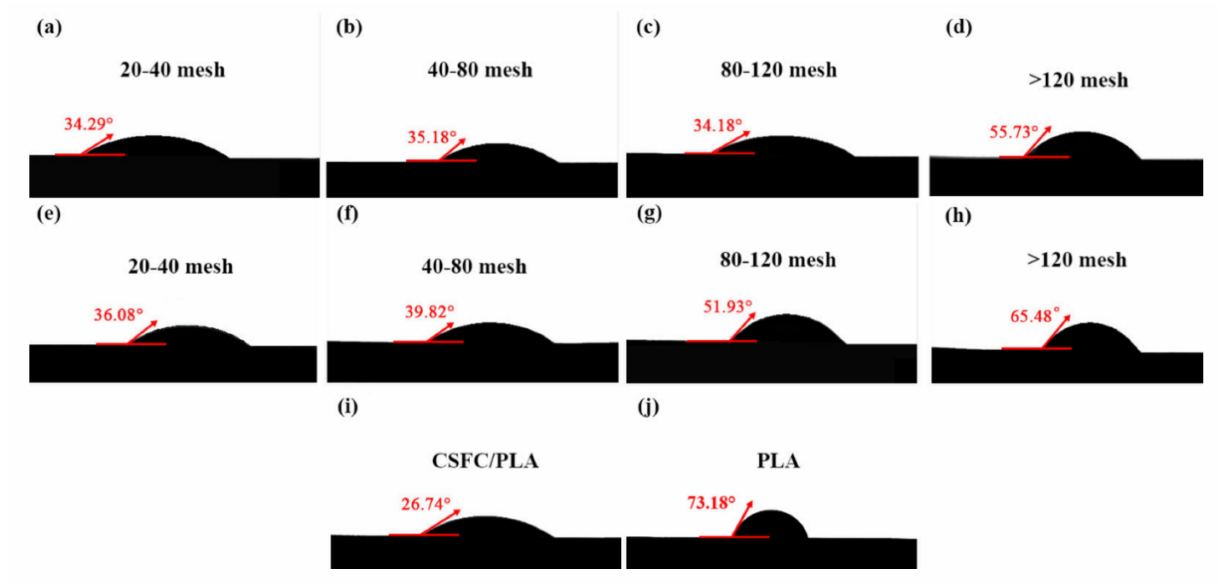
Figure 4. The contact angle change picture of CSFS/CSFC/PLA composites ( a – d ), CSFS/PLA composites ( e – h ), CSFC/PLA composites ( i ) with different particle sizes and PLA sample ( j